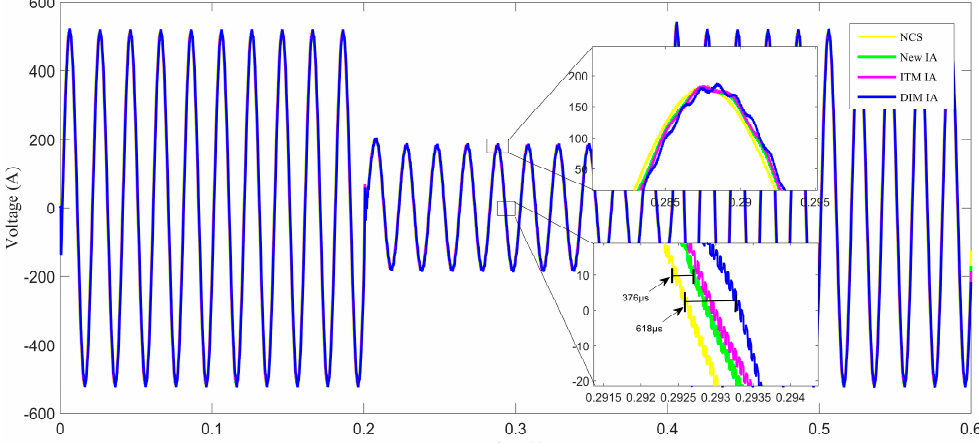
Figure 13. Grid-connected voltage waveform of RTISS with the new IA.